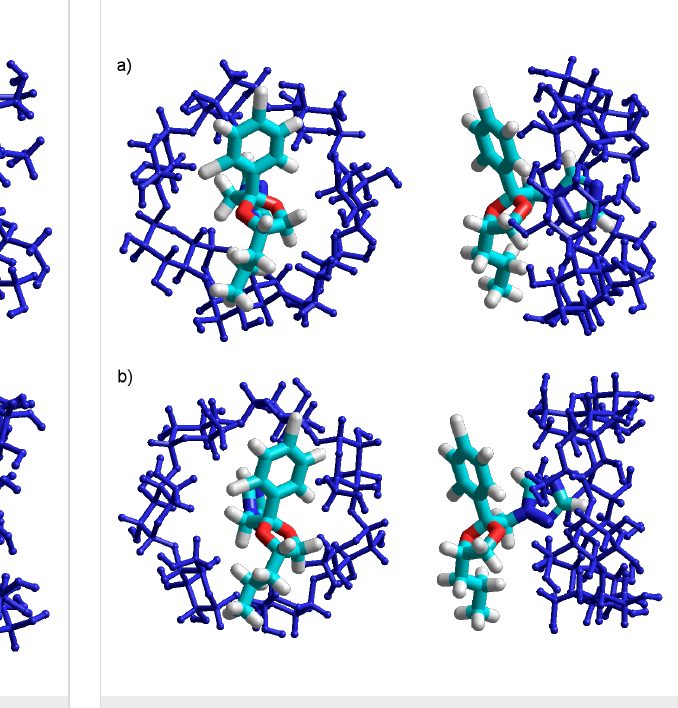
Figure 6: AM1 optimized molecular geometry of the β -CD/PP inclu- sion compounds, for both (a) A and (b) B configurations.